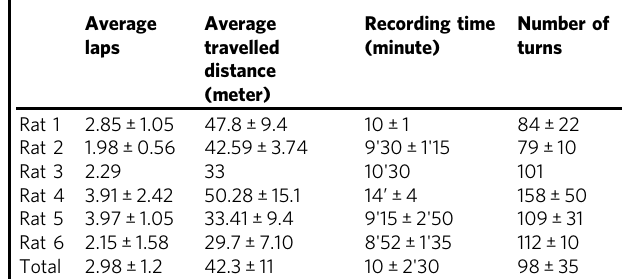
the fi ring map of each lap relative to the map of the previous lap (Supplementary Figure 3). If grid cells fi re according to a path- integrated distance process, the distance correction will align the fi ring fi elds from lap to lap and consequently induce greater spatial correlation values (Fig. 2e, Path integrated coding). In agreement with this hypothesis, spatial correlation was signi fi - cantly greater after the path integrated distance correction than in pure allocentric coding (Fig. 2e; paired t -test on Z scores: t 63 = − 2.22, p < 0.05). To control for a possible bias in this analysis, we computed the same spatial correlation analysis after splitting the path integrated fi ring map in two equal halves for 28 cells in which the animal ran at least 4 laps. We extracted the NATURE COMMUNICATIONS| (2019) 10:840